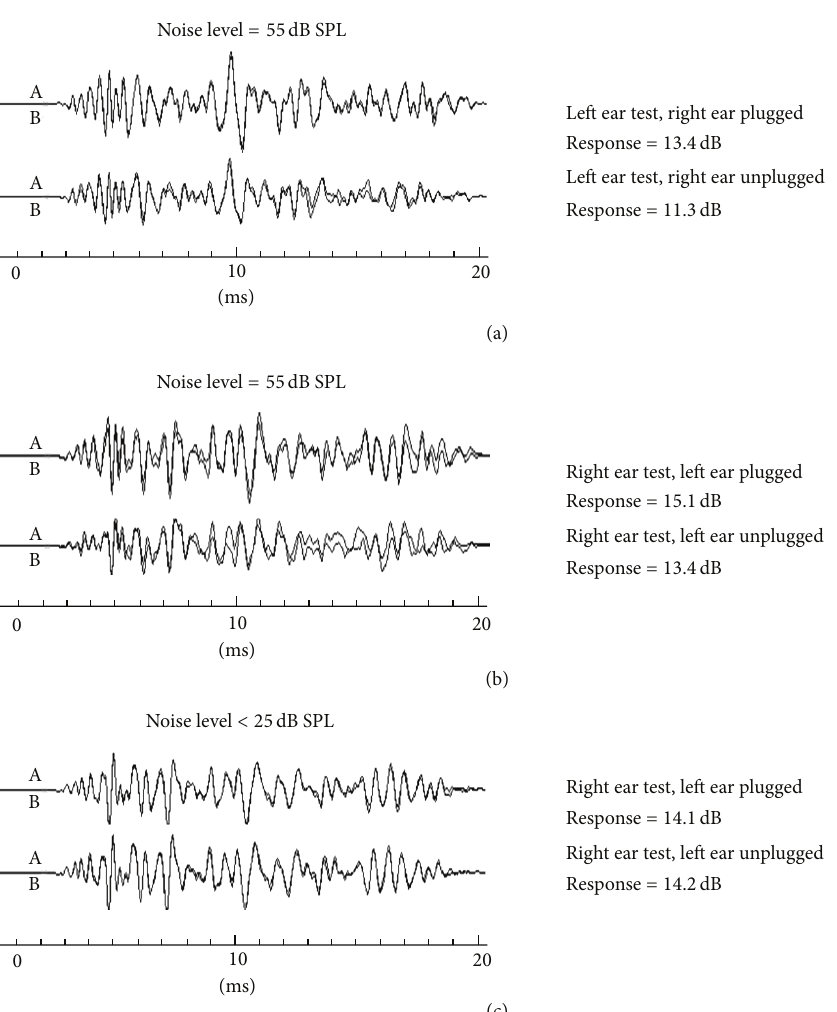
Figure 1: Differences in TEOAE wave forms (ILO88 format) measured with contralateral ear canal plugged or open, in 55 dB SPL ambient noise level ((a) and (b)) versus noise levels < 25 dB SPL (c). Data shown are from one